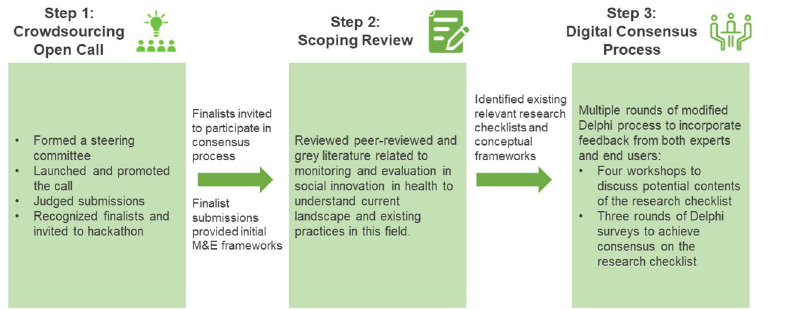
Fig 1. Overview of the process of developing consensus. M&E, monitoring and